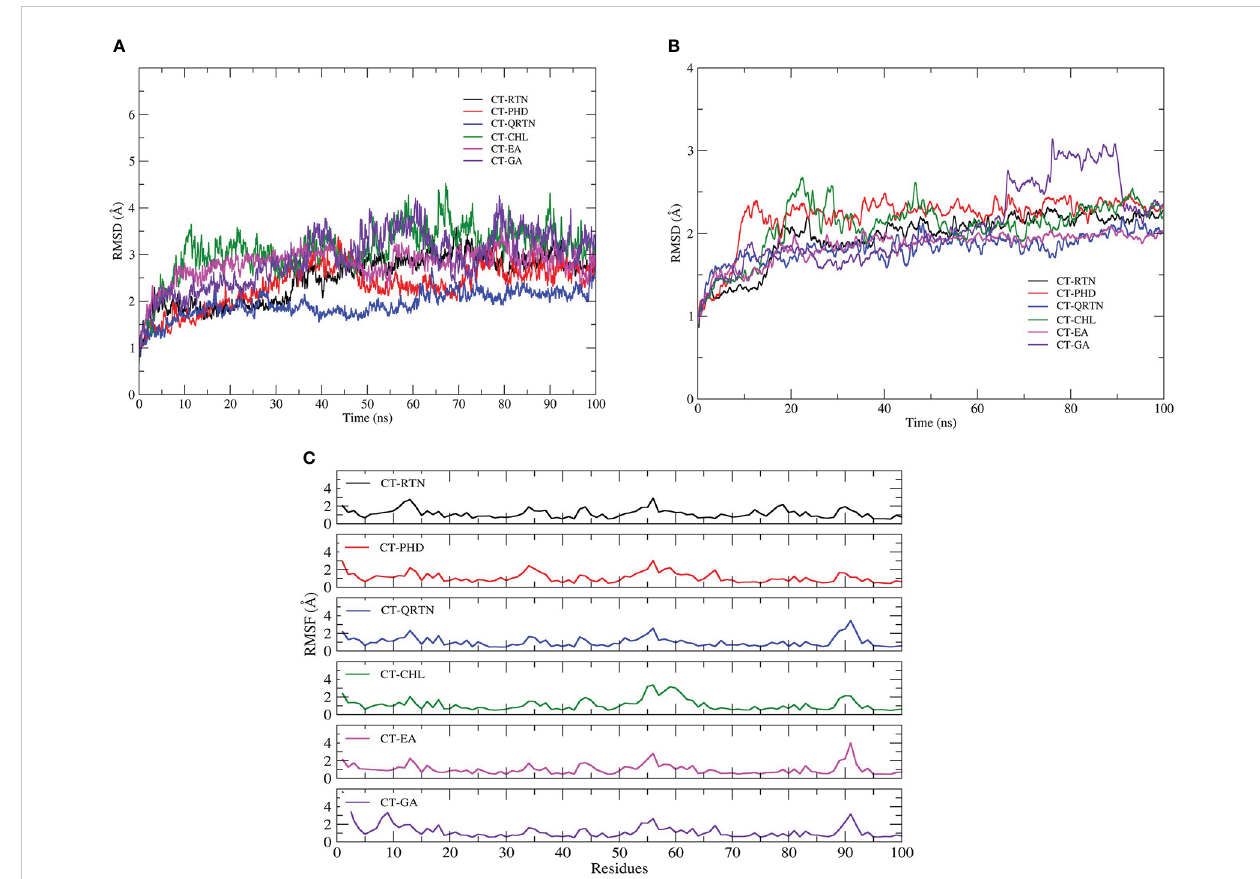
FIGURE 4 (A) The structural stability of the simulated complexes analyzed by plotting backbone RMSD of CT-complexes (B) RMSD of chain F i.e. GM1 binding pocket (C) Residual fl uctuations of GM1 binding